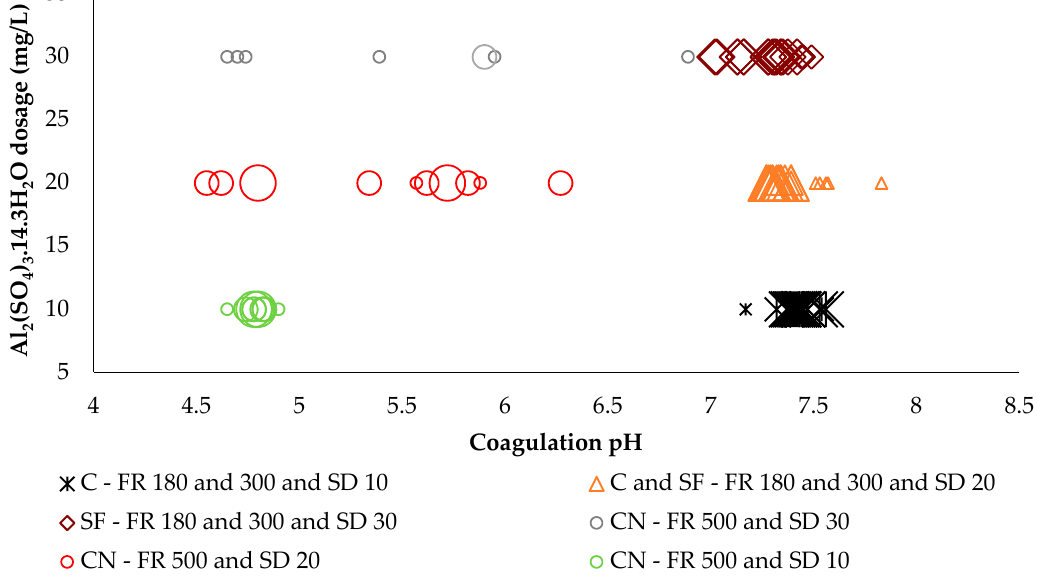
in the adsorption and charge neutralization mechanism, or in the combined mechanism.